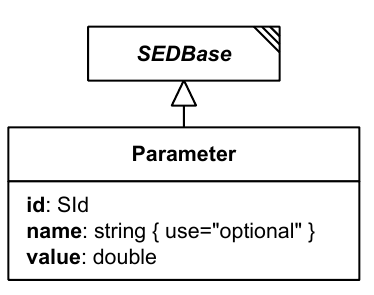
Figure 2.5: The Parameter class